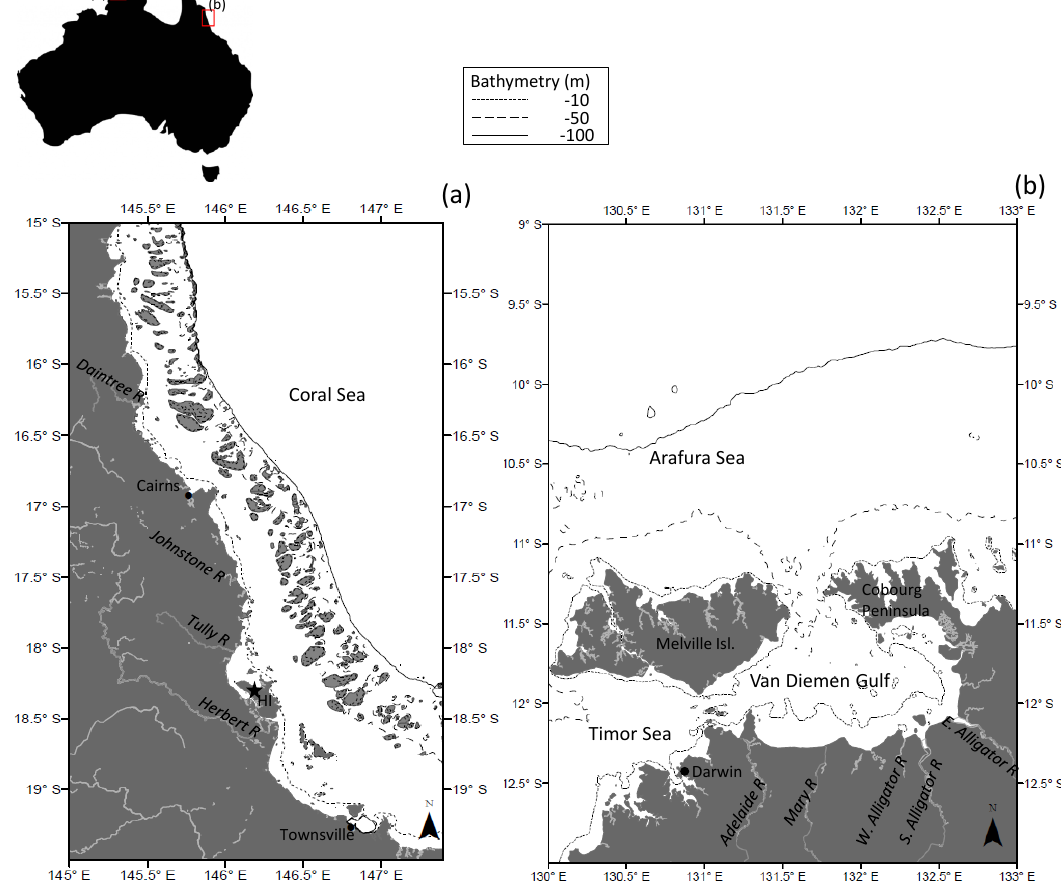
Figure 1. Maps showing the two tropical study regions. ( a ) The Great Barrier Reef (Wet tropics), Queensland. Hinchinbrook Island is shown as ―HI‖; ( b ) the Van Diemen Gulf, Northern Territory. The main rivers are indicated in italic and light grey. Isobaths (−10, −50, −100 m) are